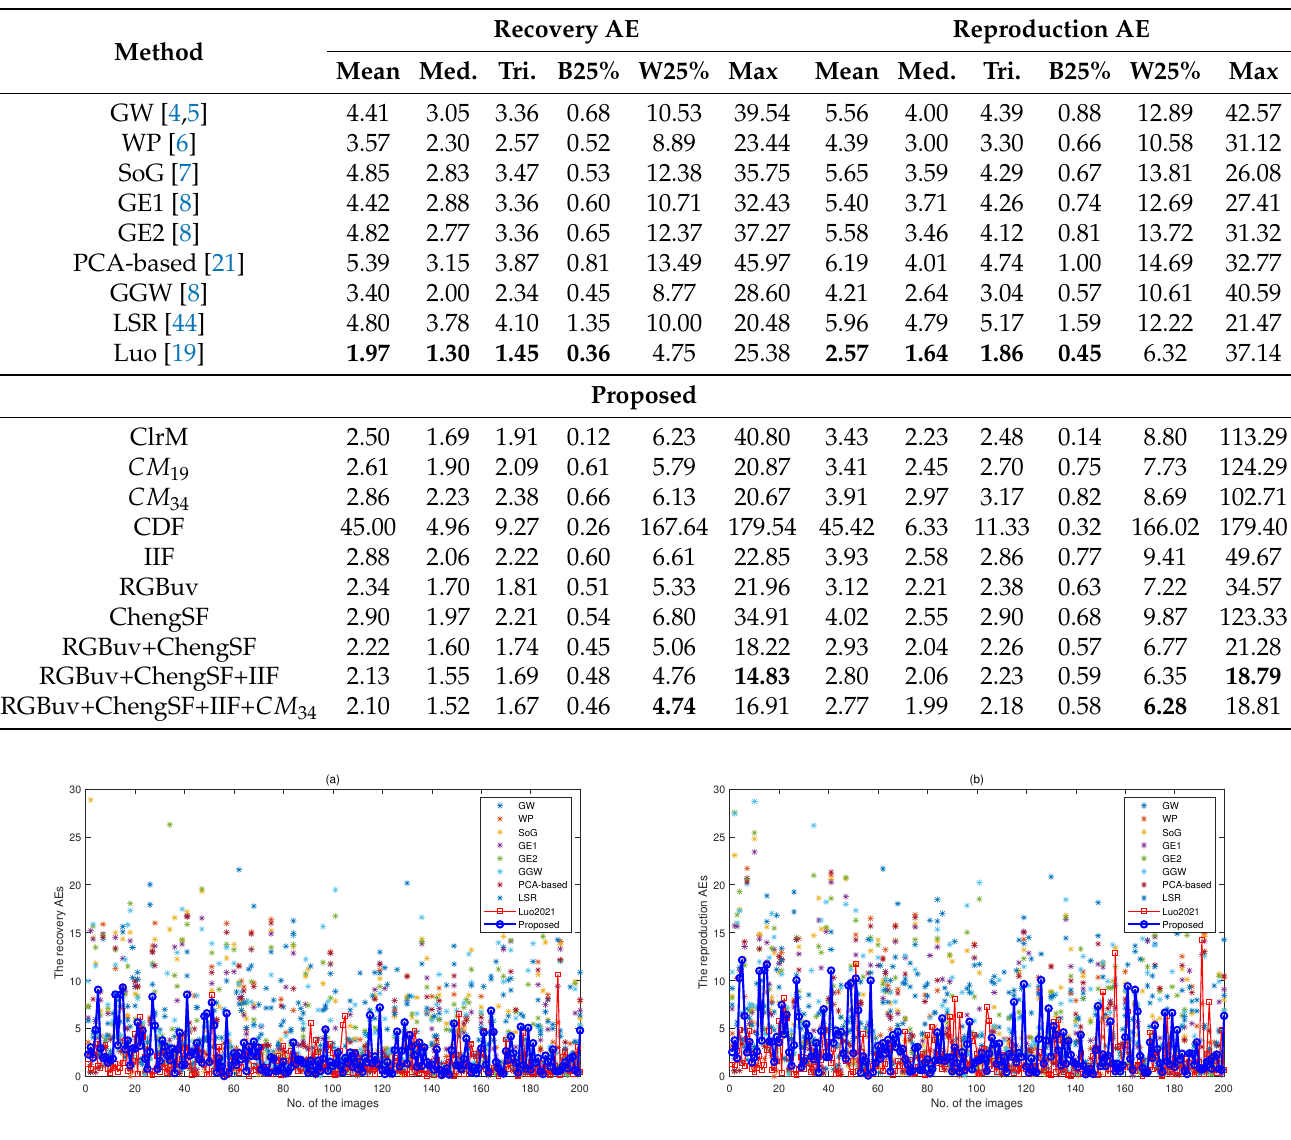
Figure 2. The recovery and reproduction AEs’ distributions for some conventional methods versus the proposed method with the combined features. In the two subfigures ( a , b ), the images of No. 1~50 refer to the first 50 images in the Gehler-Shi dataset, and the images of No. 51~200 refer to the first 150 images the Cube+